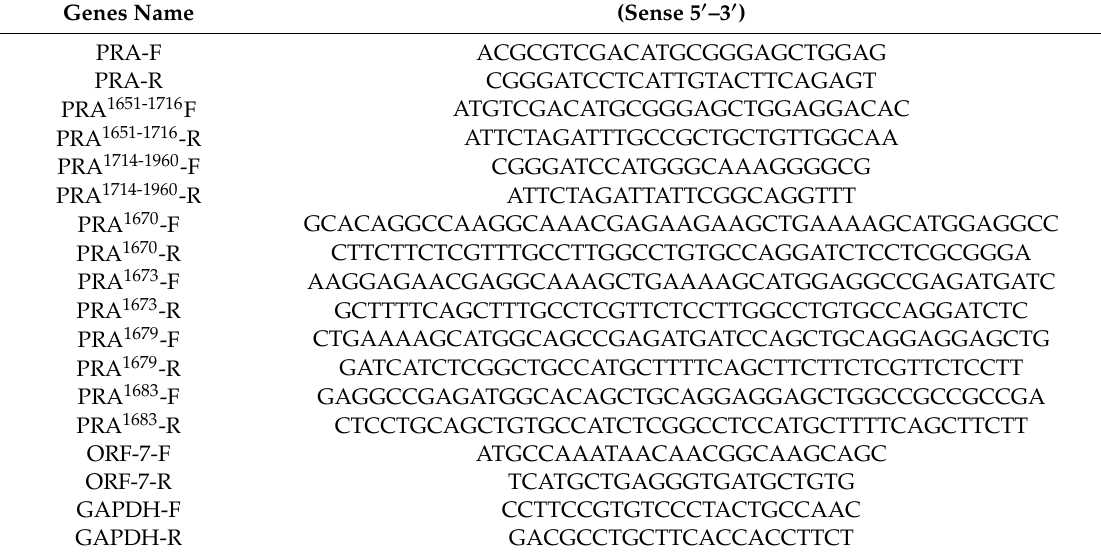
Table 1. Primers used to construct PRA (C-terminal domain of MYH9), truncated PRA, and site-directed PRA mutants and